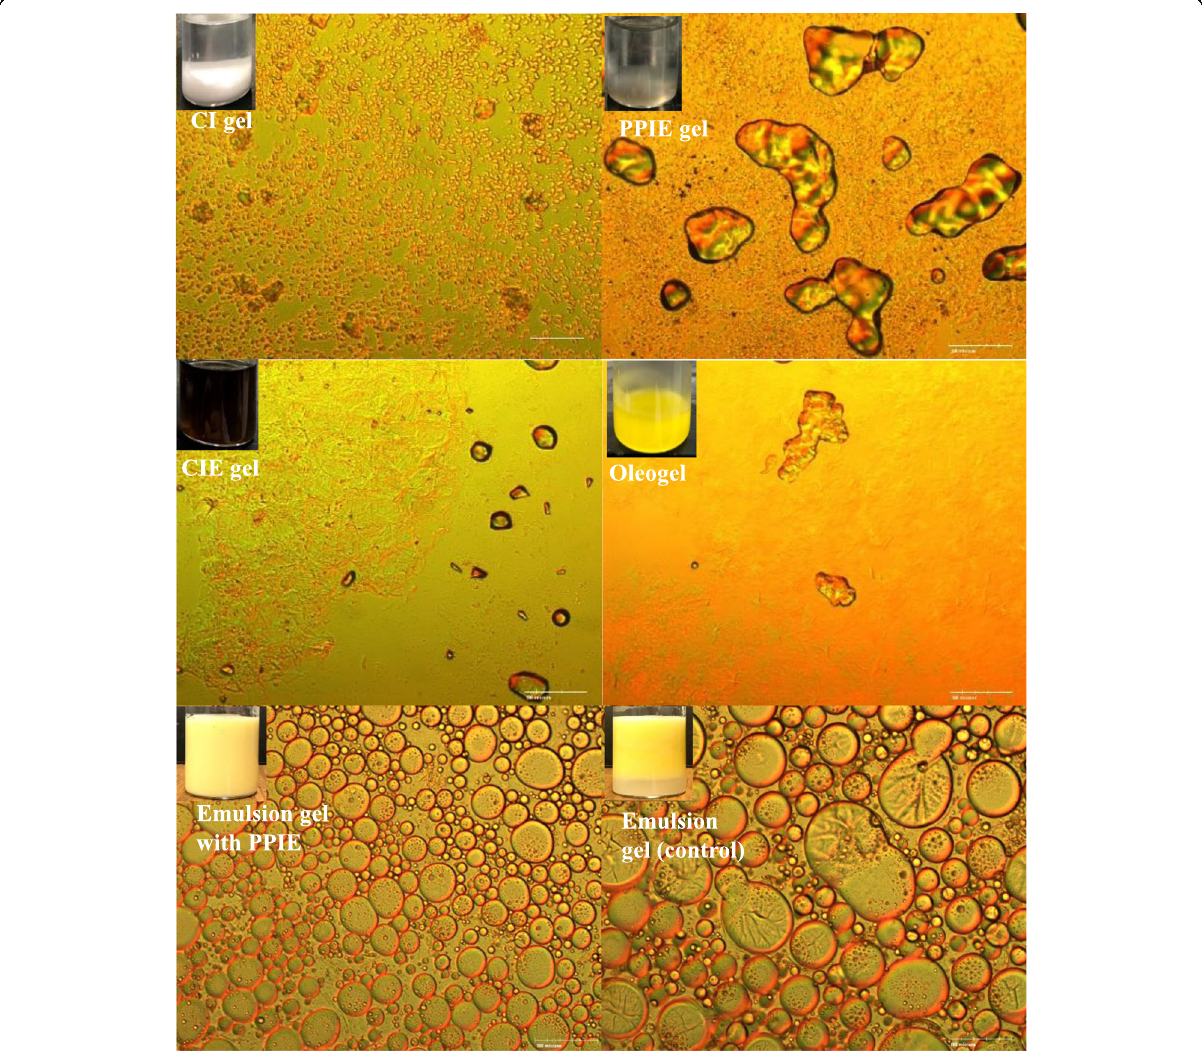
Fig. 4 Polarized light microscope images of gels and emulsion gels. The first two rows from the top indicate inulin gels and/or oleogel; the third row shows emulsion gel with 1% PPIE and without PPIE (control). CI: commercial inulin from chicory root; PPIE: primary purified inulin extract from JA; CIE: crude inulin extract from JA; MGs: monoglycerides; oleogel is formed by MGs; magnification: 200x; scale bar =100 μ